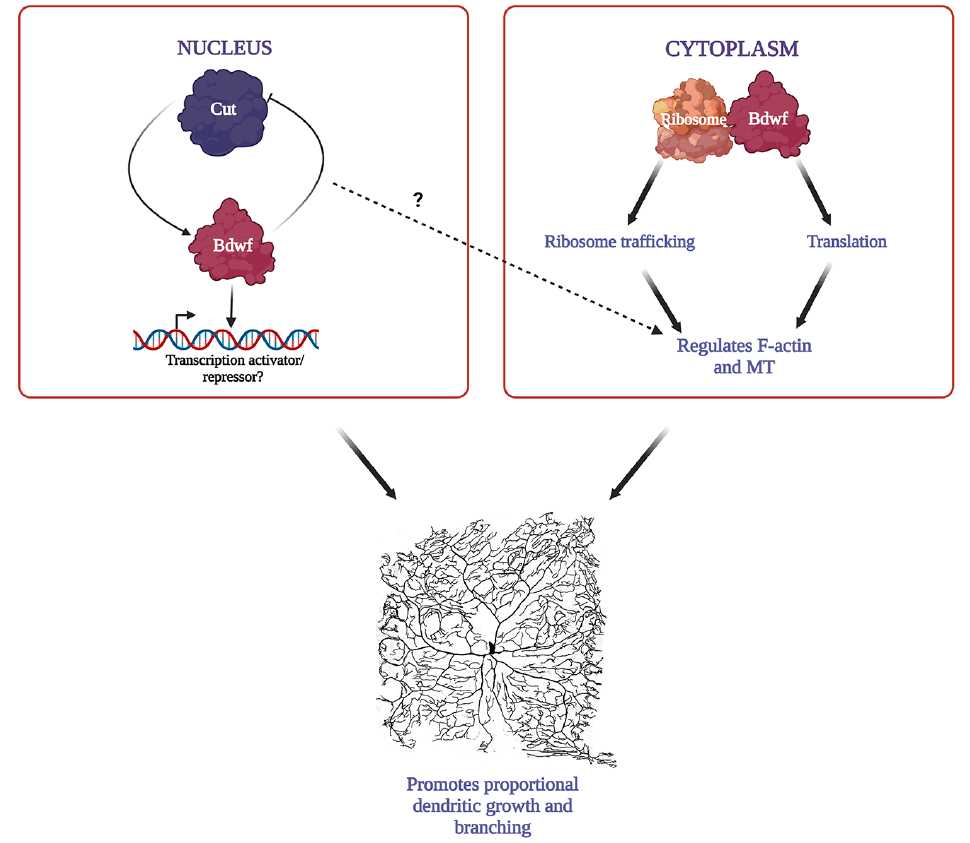
Figure 9. Model for Bdwf function in dendrite morphogenesis. Cut and Bdwf have a reciprocal regulatory relationship whereby Cut positively regulates Bdwf expression, and overexpression of Bdwf negatively regulates Cut expression. Bdwf has putative DNA-binding activity. Bdwf interacts with ribosomal proteins to form a ribonucleoprotein complex, which potentially impacts ribosome trafficking and protein translation. Bdwf modulates cytoskeletal structure by promoting MT and F-actin-dependent dendritic growth and branching in Cut-positive neurons. Since both Cut and Bdwf regulate dendritic cytoskeletal components, it is currently unknown whether this occurs through a direct mechanism of nuclear Bdwf.